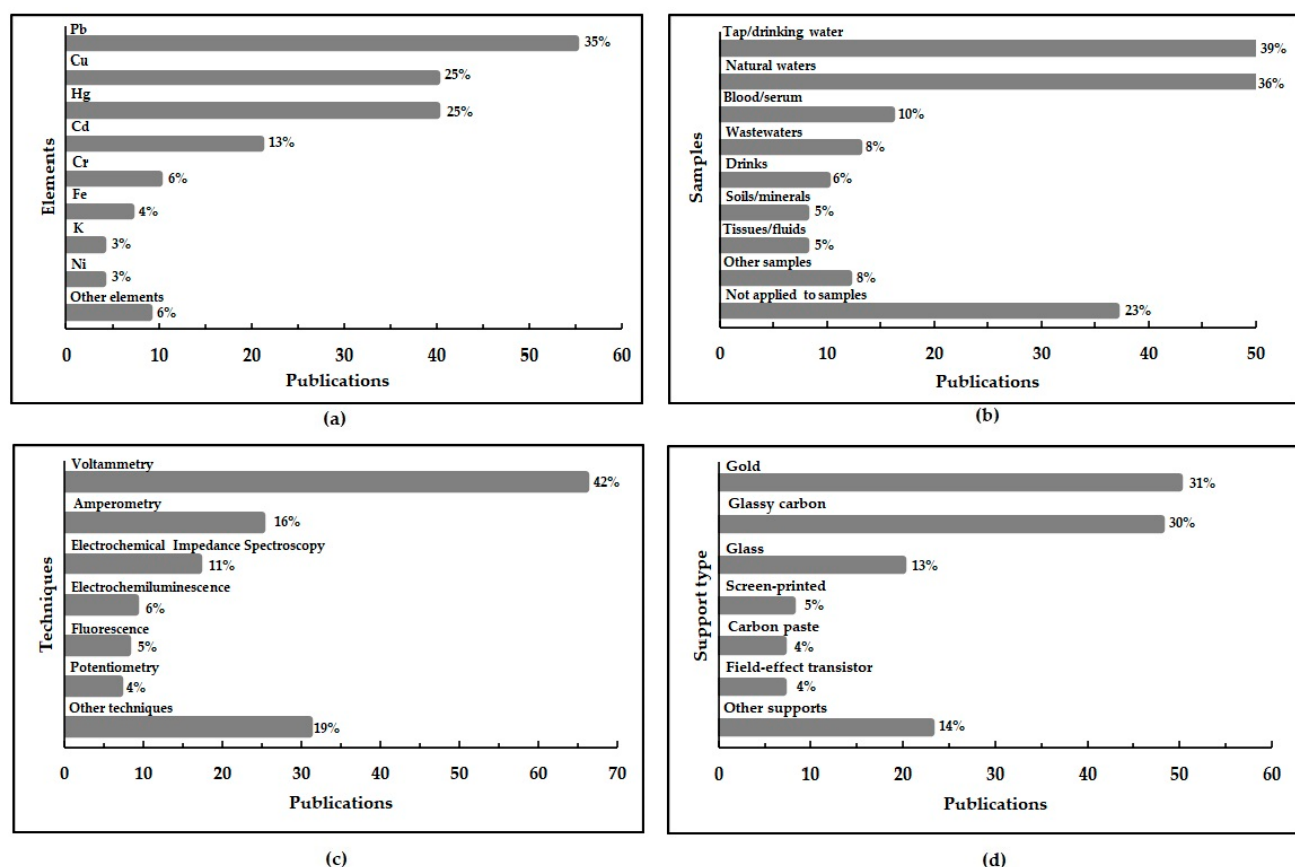
Figure 2. Overview of the applications of biosensors for metal ions determination. ( a ) analytes, ( b ) samples, ( c ) analytical techniques, and ( d ) types of platforms. The fractions were calculated based on the selected articles.